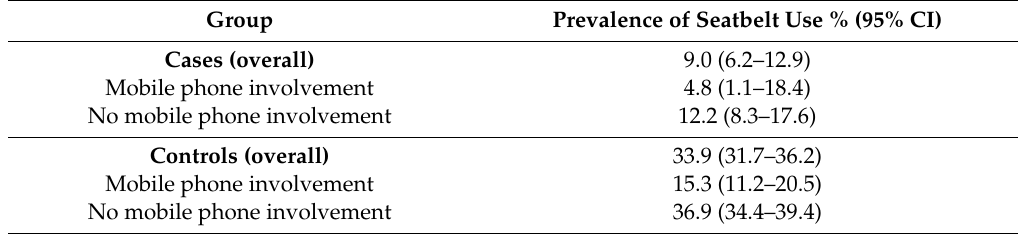
Table 3. Seatbelt use among cases and controls by mobile use status.